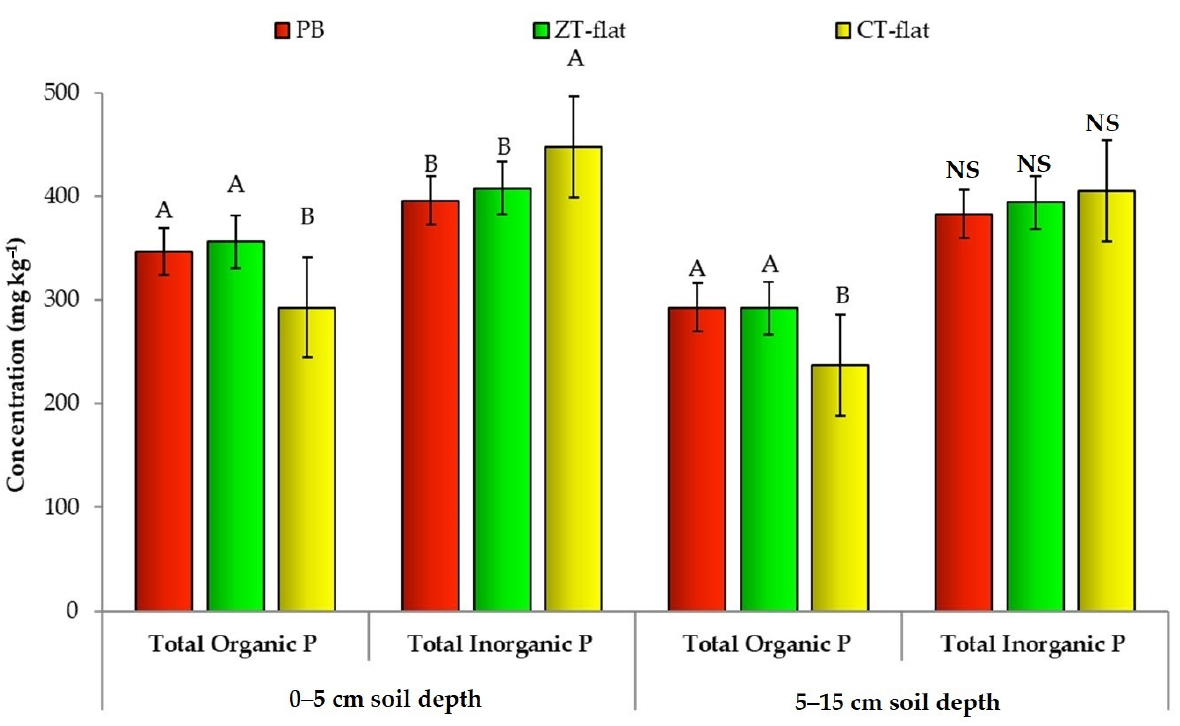
Figure 3. Effect of long-term tillage practices tillage practices on total organic and total inorganic P (mg kg –1 ) content at different soil depths. Different letters (A and B) for each parameter show significant difference at p ≤ 0.05 by Duncan’s Multiple Range Test. NS: Non-significant difference.